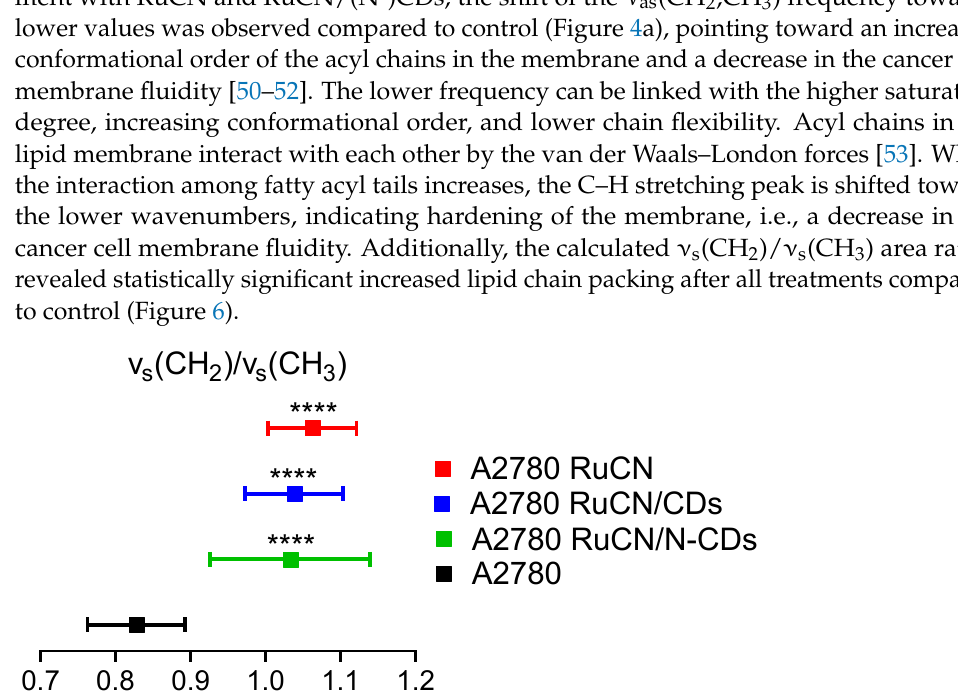
Figure 7. PCA loadings of the first two components (PC1 and PC2) of ν (C–H) vibration region ( a ) and corresponding PCA score plot ( b ). PCA loadings of the first two components (PC1 and PC2) of ν (C=O) vibration region of lipids ( c ), and corresponding PCA score plot denote the variability asso- ciated with the first two components ( d ). PCA scores of ν (C–H) and ν (C=O) in the lipid region (Figure 7b,d) show that un- treated A2780 cells (control, black dots) and cells treated with RuCN (red dots) are clearly differentiated from other groups of treated cells. While the PC2 scores for untreated A2780 cells show mostly positive values, the PC2 scores for cells treated with RuCN show